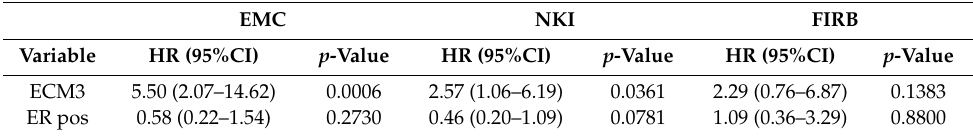
Figure 2. ECM3 prognostic significance in HER2-positive BC patients. ( a , b ) Association between ECM3 (red line) and non-ECM3 (black line) and disease-free survival (DFS) in untreated HER2-positive BC patients of the EMC ( a , n = 49) and NKI ( b , n = 52) datasets. ( c ) Association between ECM3 and non-ECM3 and DFS in HER2-positive BC patients (FIRB cohort) treated with adjuvant chemotherapy without trastuzumab. p -values by log-rank test. Table 2. Multivariate proportional hazard analyses of DFS.